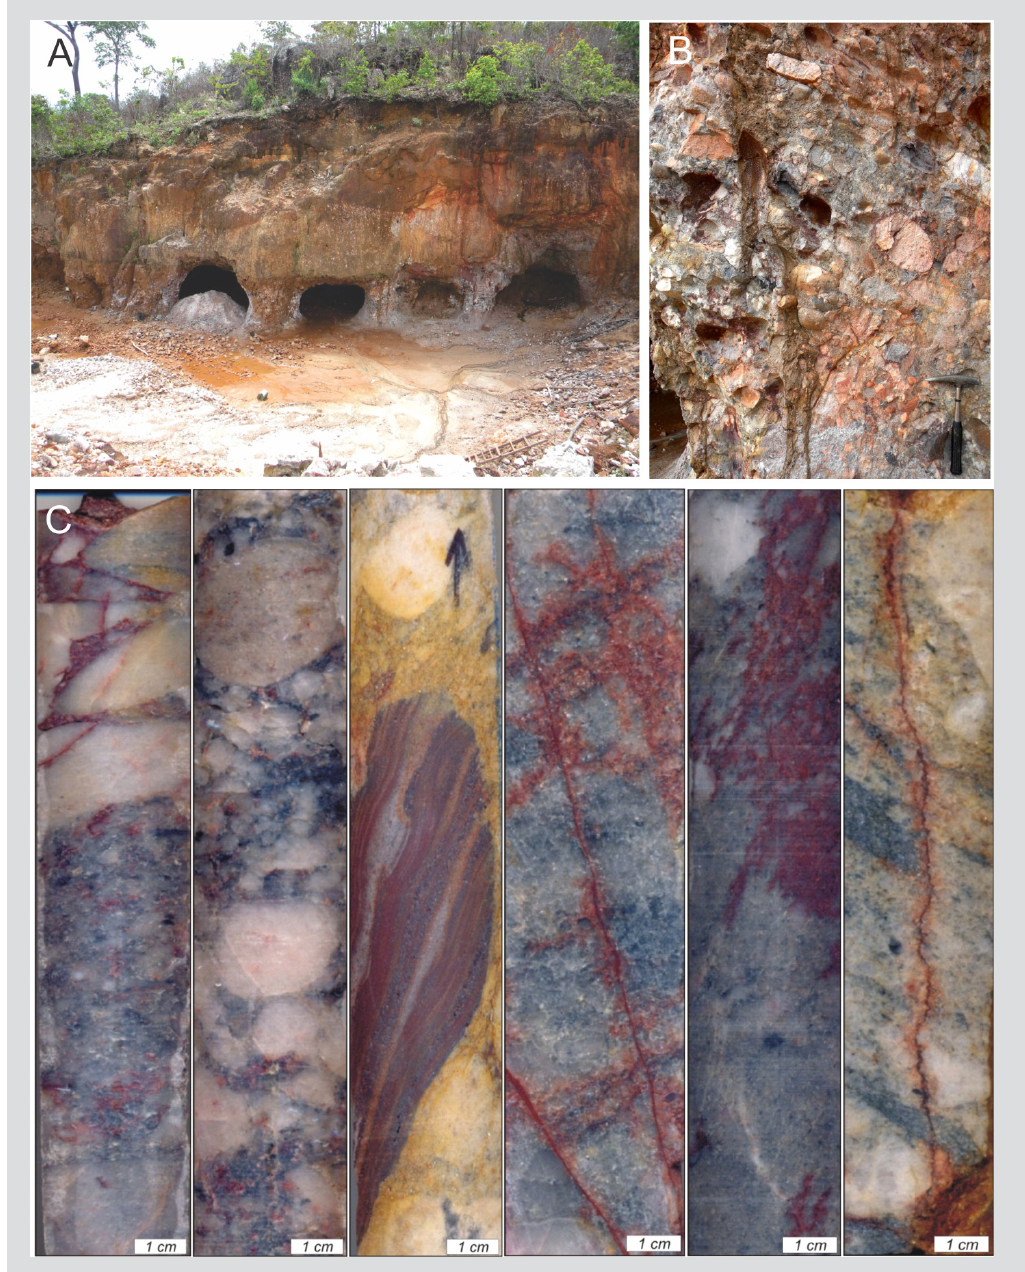
Figure 5 - Images of metaconglomerates of the Castelo de Sonhos deposit. (A) General view of an artisanal mining pit. (B) Closer view of the clast-supported metaconglomerate, with pebbles of variable shapes and sizes. (C) Drill cores showing, from left to right: impregnation of secondary iron oxides in the matrix and in fractures; clast-supported metaconglomerate; clast of banded iron formation; fractures coated by secondary iron oxides; strong impregnation of the matrix with secondary iron oxides; fracture coated by secondary iron oxides cutting across matrix and